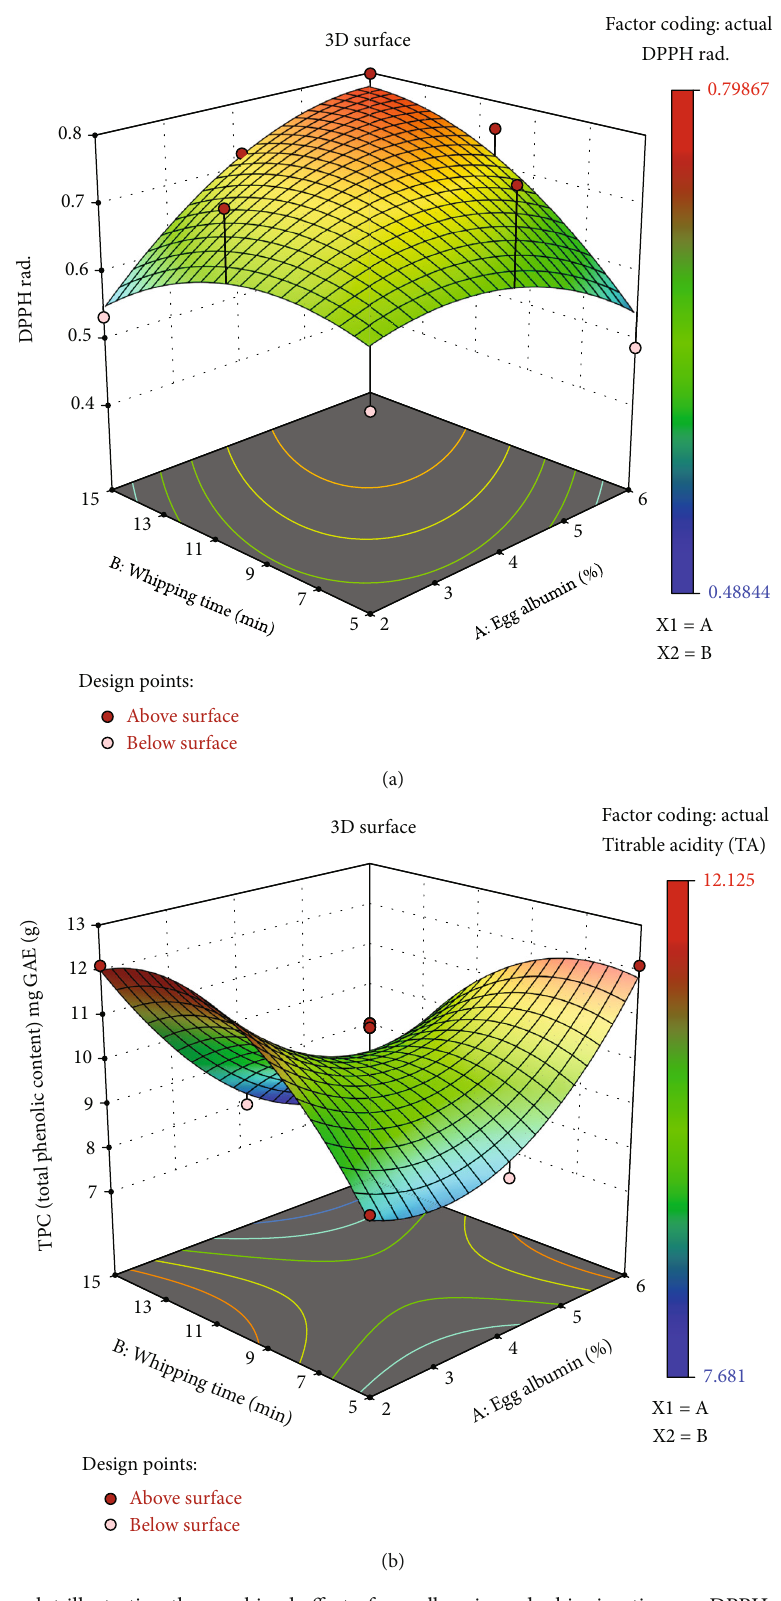
Figure 7: Response surface plot illustrating the combined e ff ect of egg albumin and whipping time on DPPH scavenging activity (a) and TPC